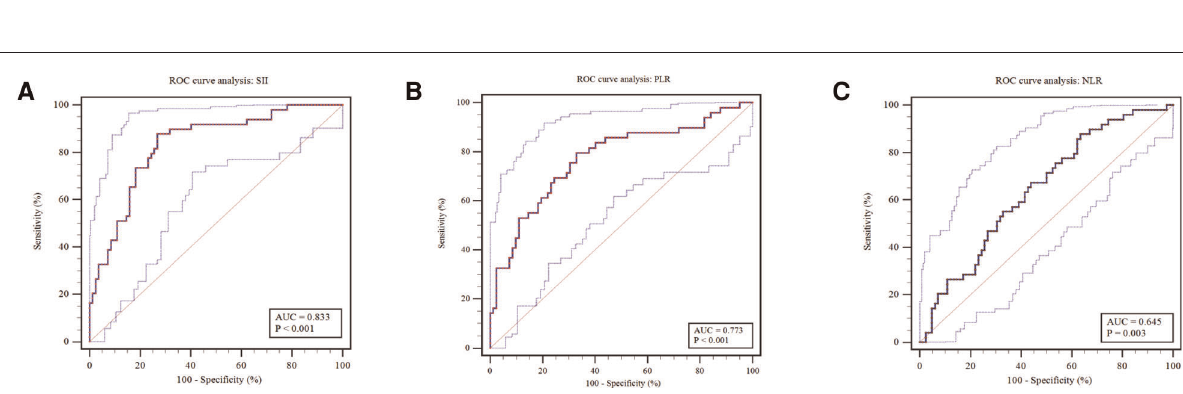
FIGURE 2 Comparison of ( A ) SII, ( B ) PLR and ( C ) NLR values in different treatment strategies. SII, systemic immune-in fl ammation index; PLR, platelet-to- lymphocyte ratio; NLR, neutrophil-to-lymphocyte ratio.